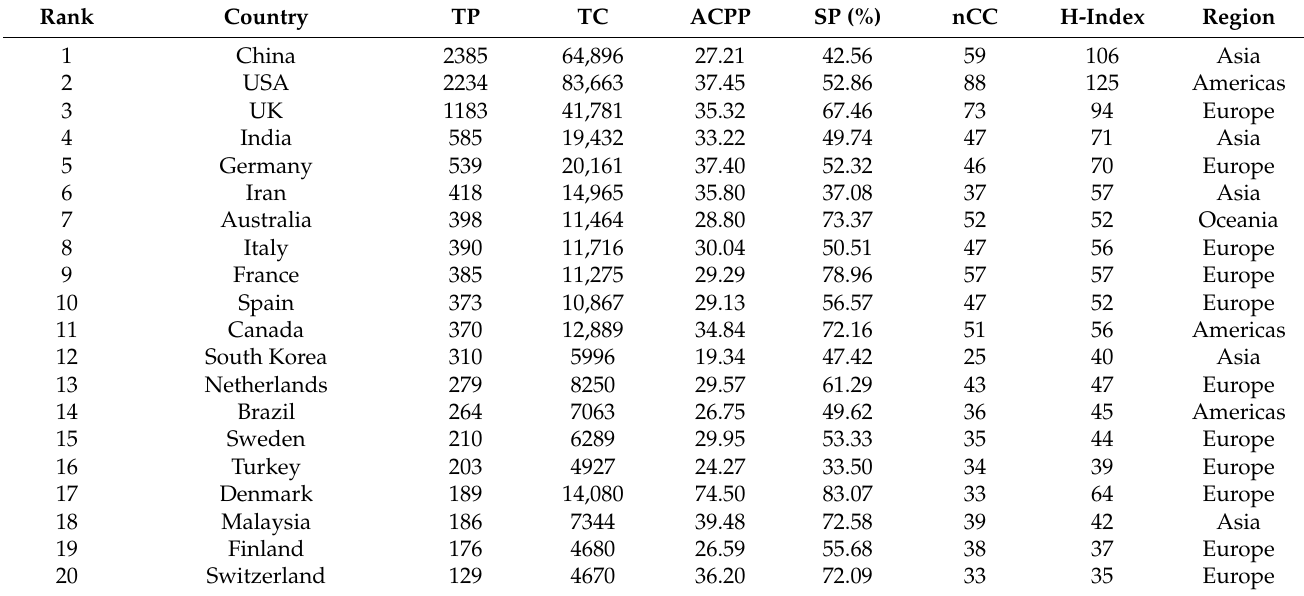
Table 3. The Top 20 Most Productive Countries/Regions During